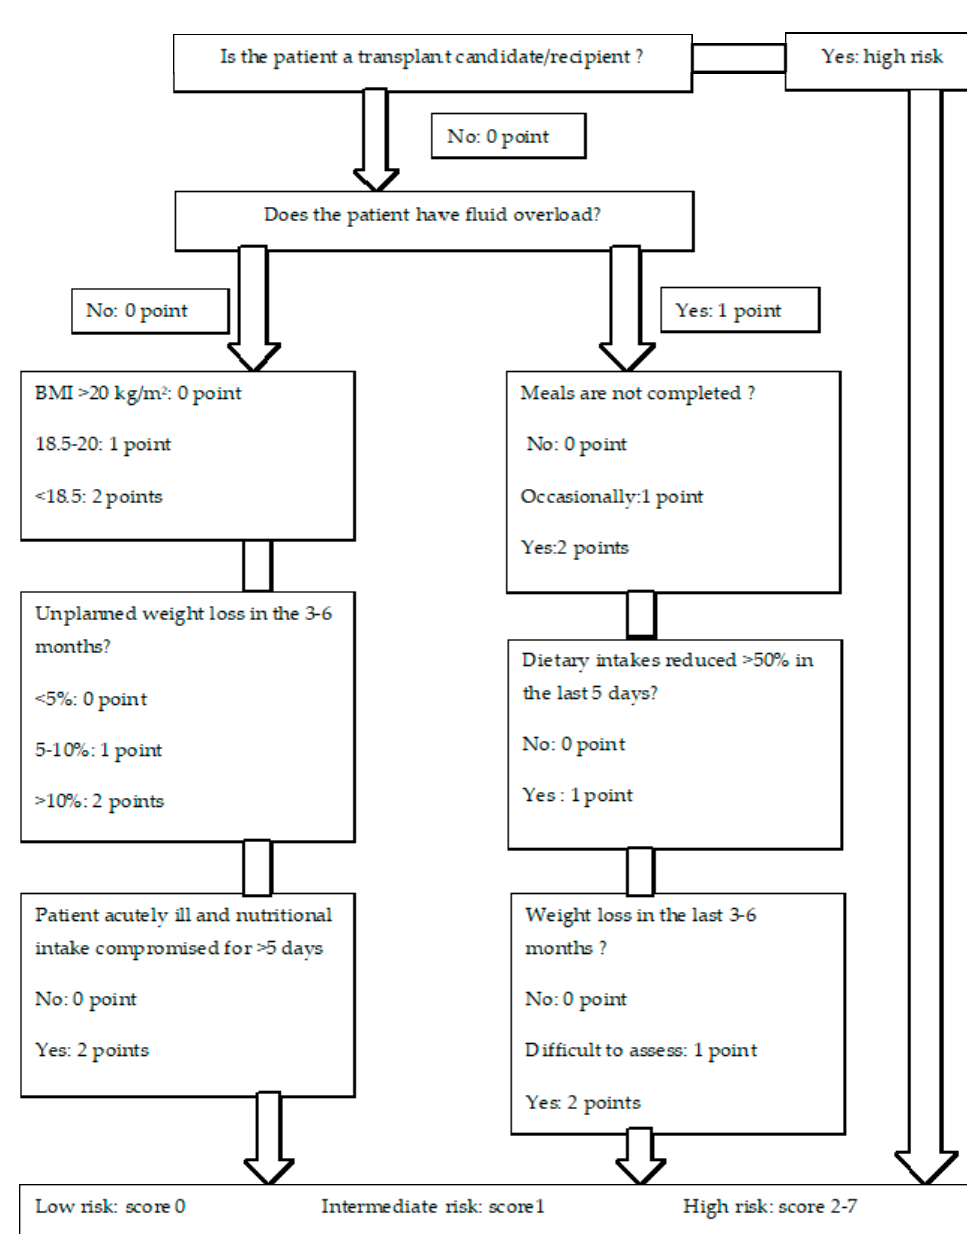
Figure A1. Royal free hospital nutrition prioritizing tool [17]. BMI: body mass index. Table A1. Liver disease undernutrition screening tool [20].